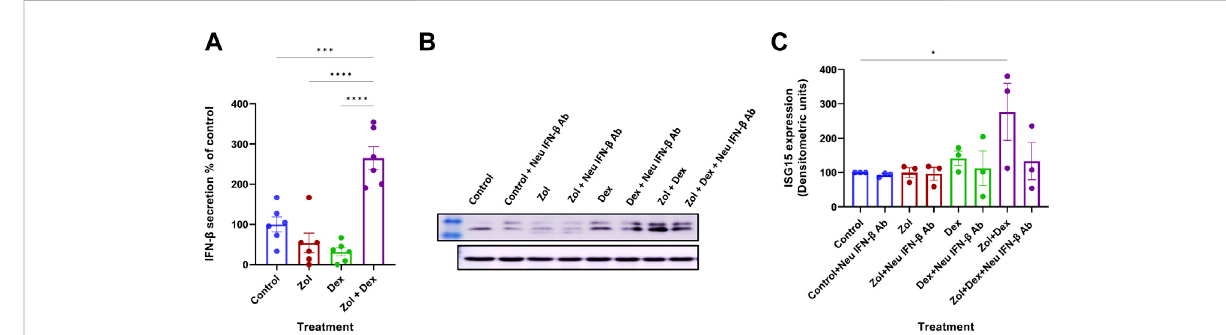
FIGURE 1 Zol+Dex promotes IFN- β secretion and ISG15 expression in RAW 264.7 macrophages. RAW 264.7 macrophages were incubated with Zol (10 µM)and/or Dex(1 µM)for 4 (A) or 24 h (B,C) . Then, culture medium was collected, andIFN- β levels were determined bystandardELISA (A,% C.V. were: Control = 45.73%, Zol = 110.6%, Dex = 76.80%, Zol+Dex = 26.41%), or cells were collected and analyzed by Western blotting for ISG15 and GAPDH (B – C) . Results are averages from 3 experiments (A,C) or representative images (B) . Statistical signi fi cance by one way ANOVA is